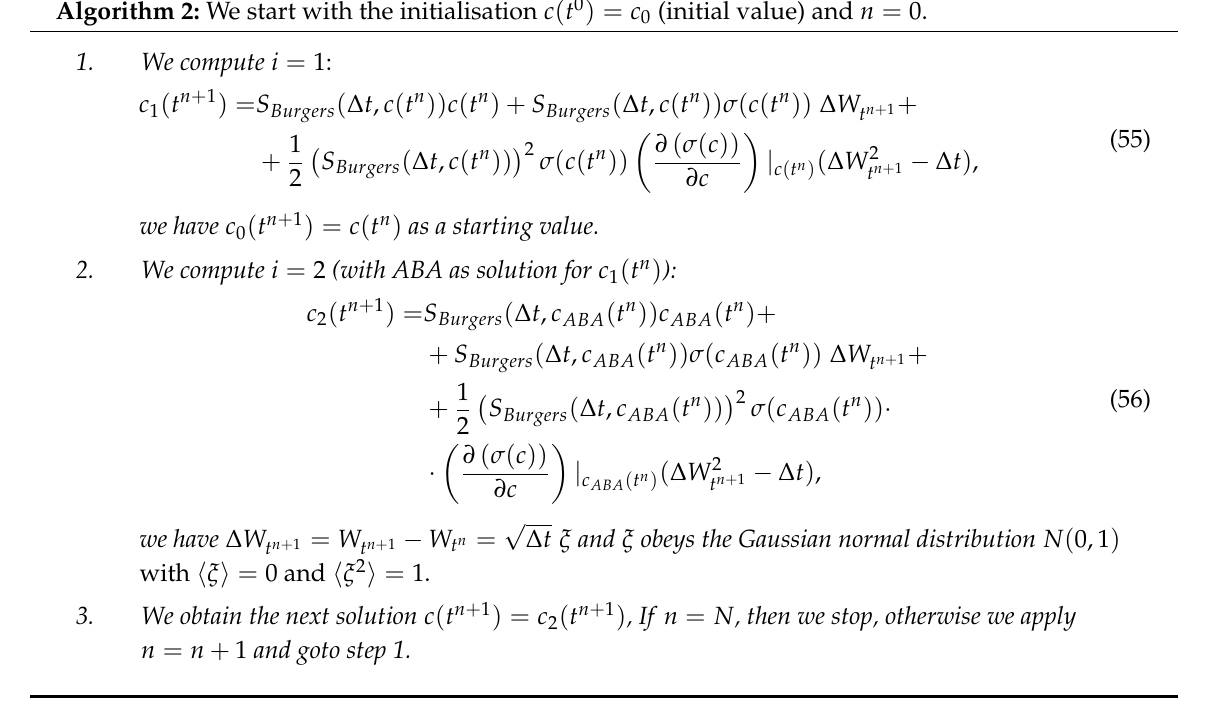
Algorithm 3: We start with the initialisation c ( t 0 ) = c 0 (initial value) and n =